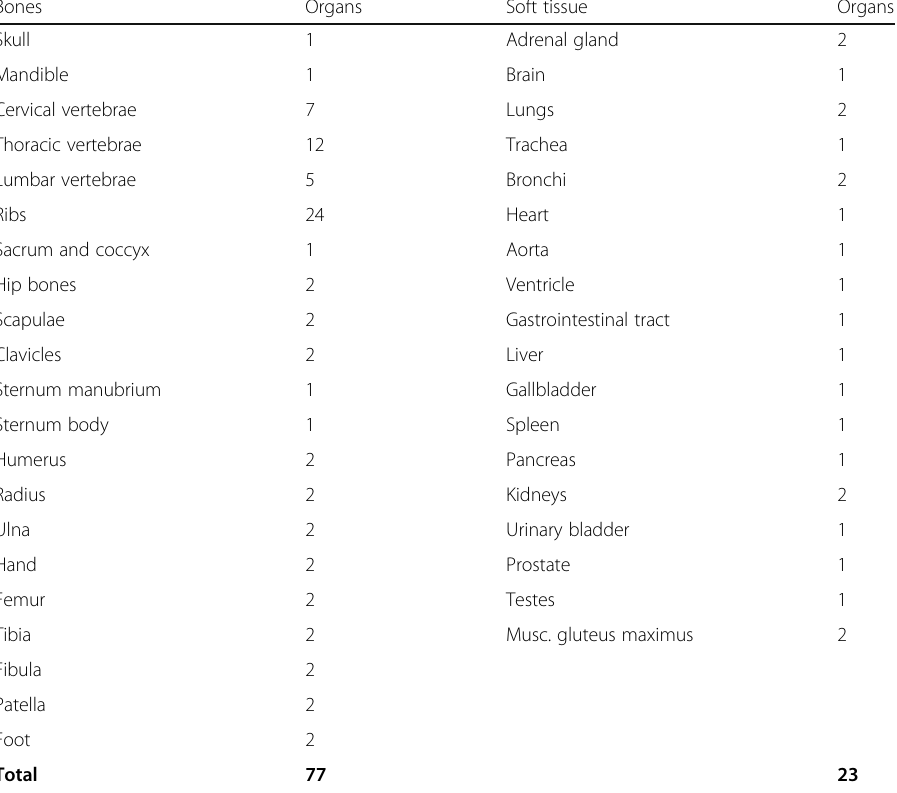
Bones Organs Soft tissue Organs Skull